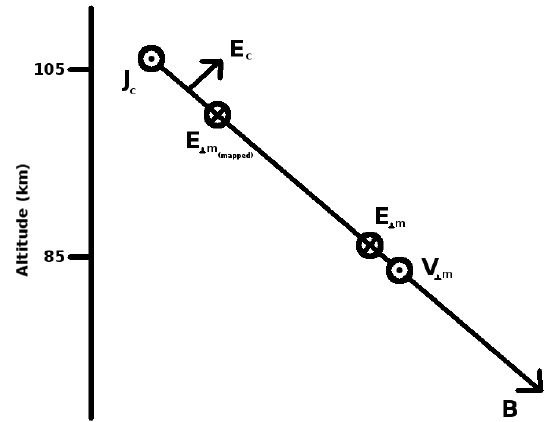
Figure 7. Geometry of the model. Here we take the optimum case for a meteor velocity perpendicular to B . The electric field gener- ated opposite of the meteor velocity maps up to the E region since the conductivity along B is very high and is the source of the elec- tromagnetic radiation needed for electrophonics. The E m field is the component we discuss below and which travels to the bottom of the F layer as a whistler pulse.